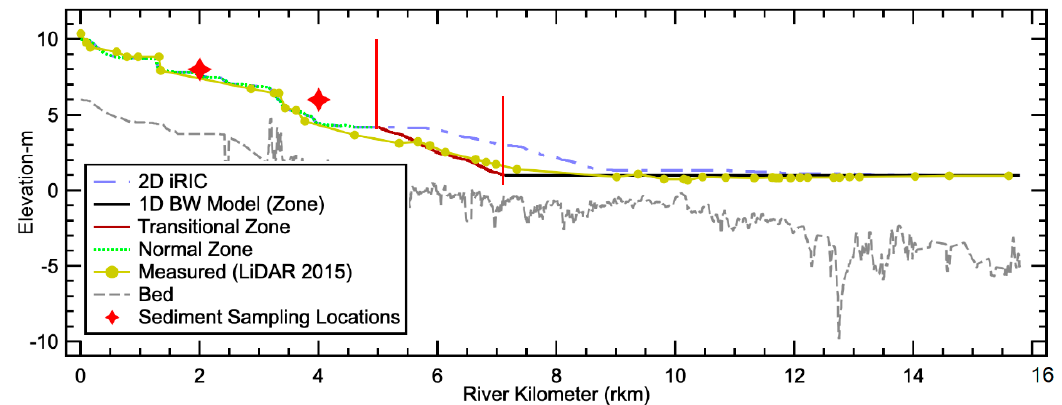
Figure 4. Water surface profile from the integrated model for the discharge of 0.42 cms is compared against measured data to verify the adjusted water surface profile. The results show the difference between the quasi-normal water surface profile obtained from the iRIC and the gradually varied flow obtained from the integrated model. The red vertical lines show the transitional zone, which indicates uncertainty in the estimated water surface elevation.